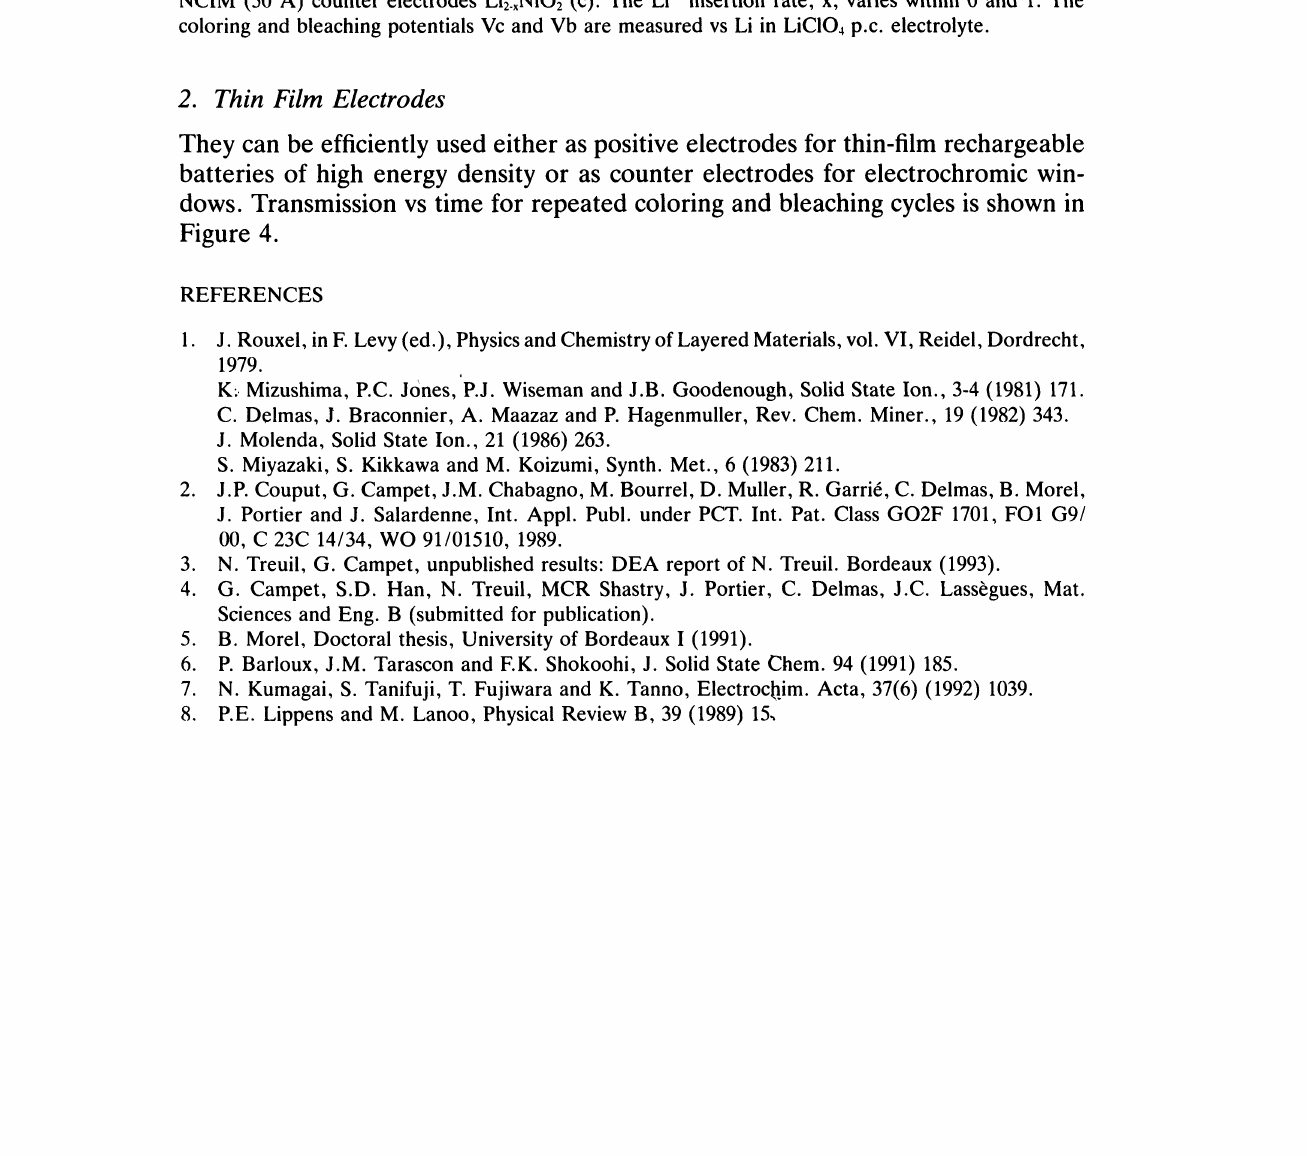
FIGURE 4 Transmission (A 550 nm) vs time for repeated coloring and bleaching cycles with the NCIM (50 l) counter electrodes Li2.xNiO2 (c). The Li insertion rate, x, varies within 0 and 1. The coloring and bleaching potentials Vc and Vb are measured vs Li in LiCIO4 p.c.